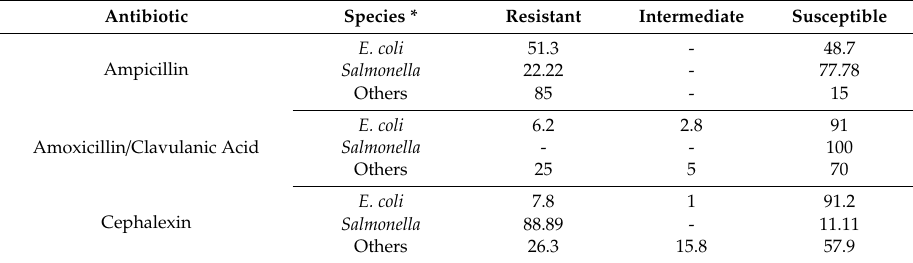
Table 4. Percentages of antimicrobial susceptibility in di ff erent bacteria